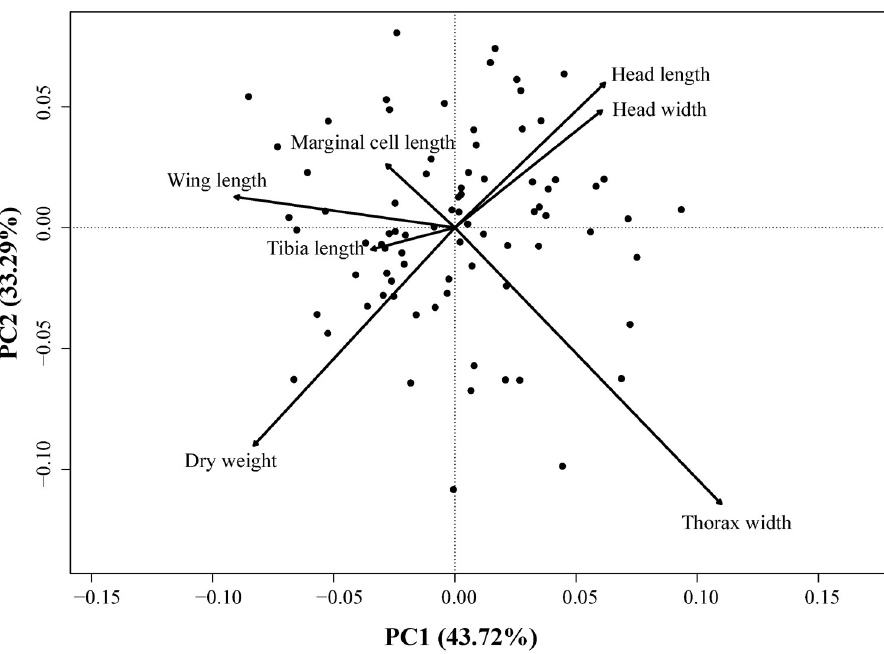
Fig 1. Principal component analysis (PCA). Plot showing the multivariate variation among 80 Bombus impatiens workers with respect to their morphometric measurements. Vectors indicate the direction of the functional trait to the overall distribution. The first two principal axes explained 77.01% of the